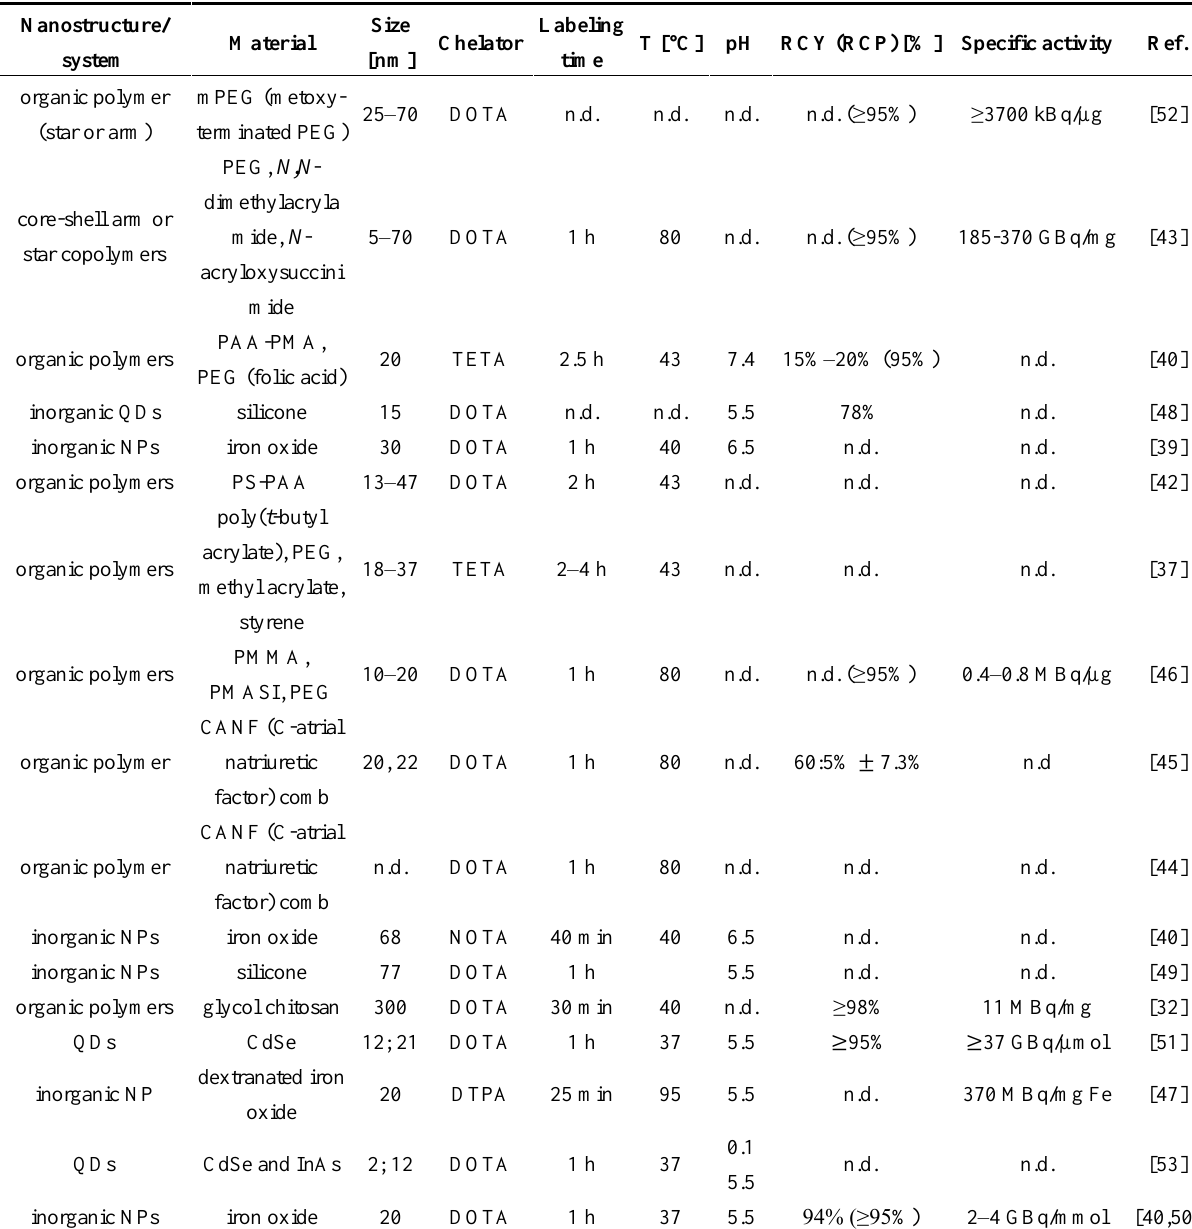
Table 2. An overview of different approaches of 64 Cu-labeled nanoparticles and polymers and important parameters. (n.d. = no data, RCY = radiochemical yield, RCP